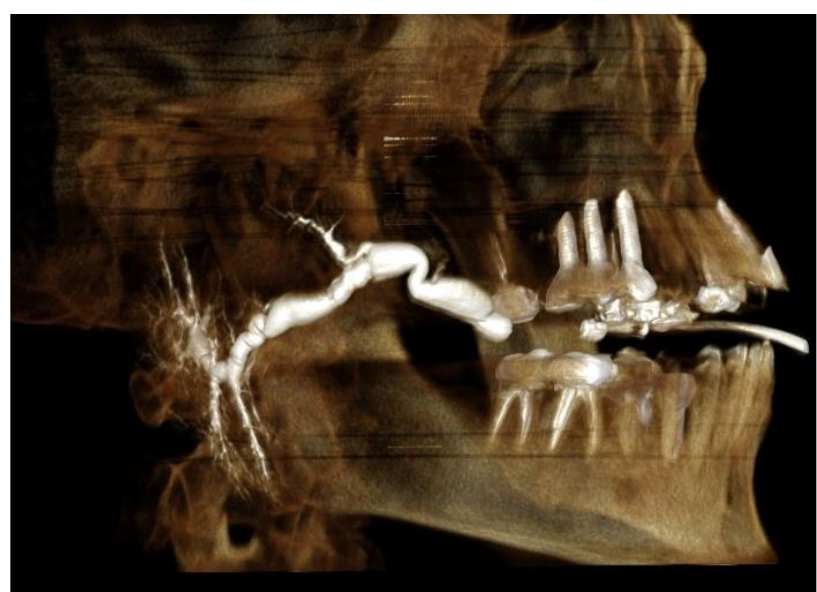
Figure 1. CBCT sialography of right parotid gland exhibiting mega duct.